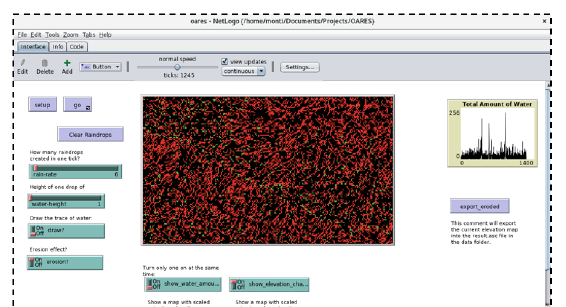
Figure 12. NetLogo Interface showing the impact of rainfall on different patches.